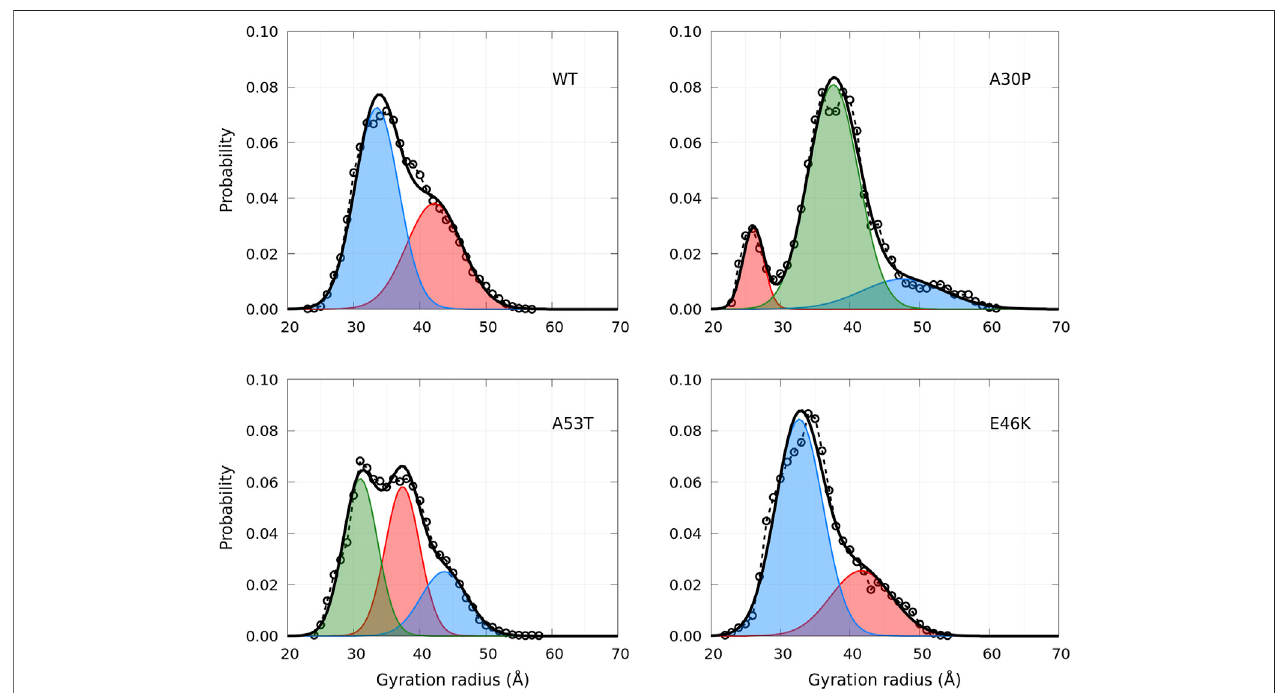
FIGURE 10 | Probability density functions of the gyration radius for the WT and mutants computed from MD simulations (circle symbols and dashed lines). Each distribution is represented by a set of Gaussians (colored areas), the number and the parameters of which were found by applying the GMM algorithm. The sum of Gaussians is represented by a full black line.